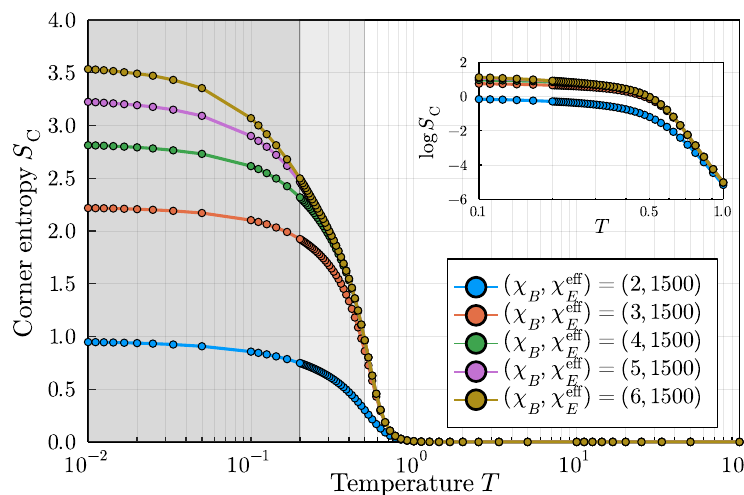
Figure 4: Corner entropy S of the fixed-point CTM corner tensors for different maxi- C mal values of the spin in the plane wave expansion and the virtual bond indices. The inset shows the region around T ≈